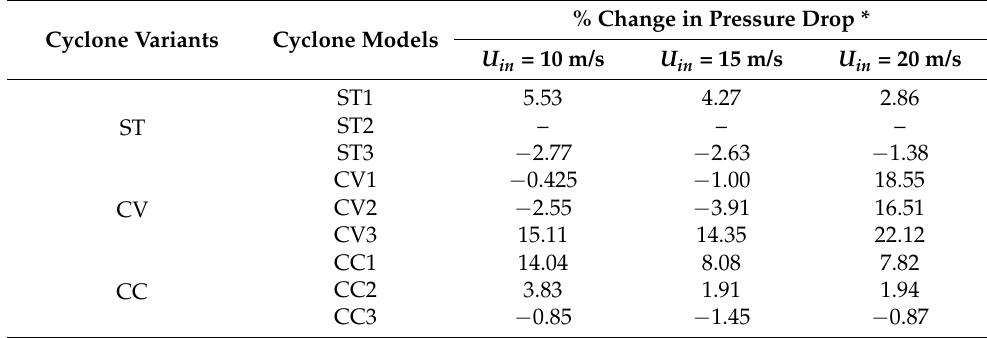
Figure 7. Pressure drop values in all the cyclone models of ST variant, CV variant and CC variant at inlet velocities, U in = 10, 15 and 20 m/s. Table 2. Pressure drop at different inlet velocities.